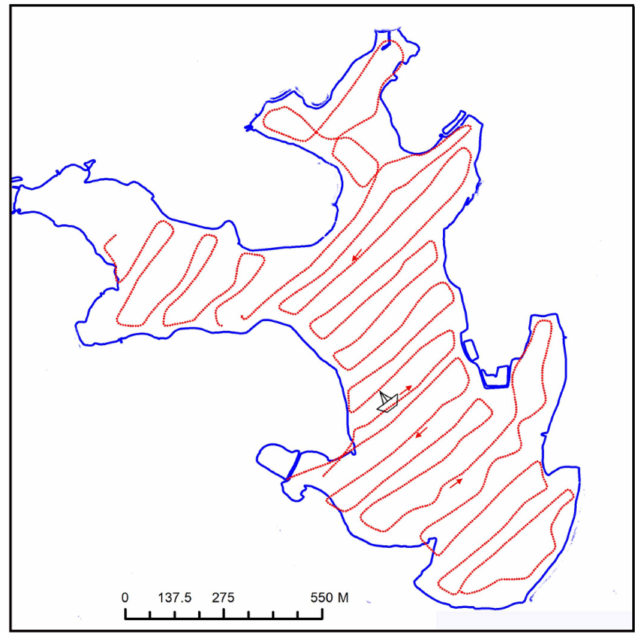
Figure 4. Map showing the trajectory of the survey ship. Each red dot indicates a measurement point. Second, the data were processed in the lab. AutoCAD and ArcGIS were used to make a digital elevation model (DEM) of the entire lake area. First, we jointly edited the existing 1:2000 topographic map of Panlongcheng and the underwater data to draw a 1:2000 digital line graph (DLG), which covered the entire site, including the areas above water and underwater. Then, based on the generated 1:2000 DLG, a triangular irregular network (TIN) was produced in ArcGIS. Finally, we transformed the TIN into a DEM in raster mode to complete the data processing (Figure